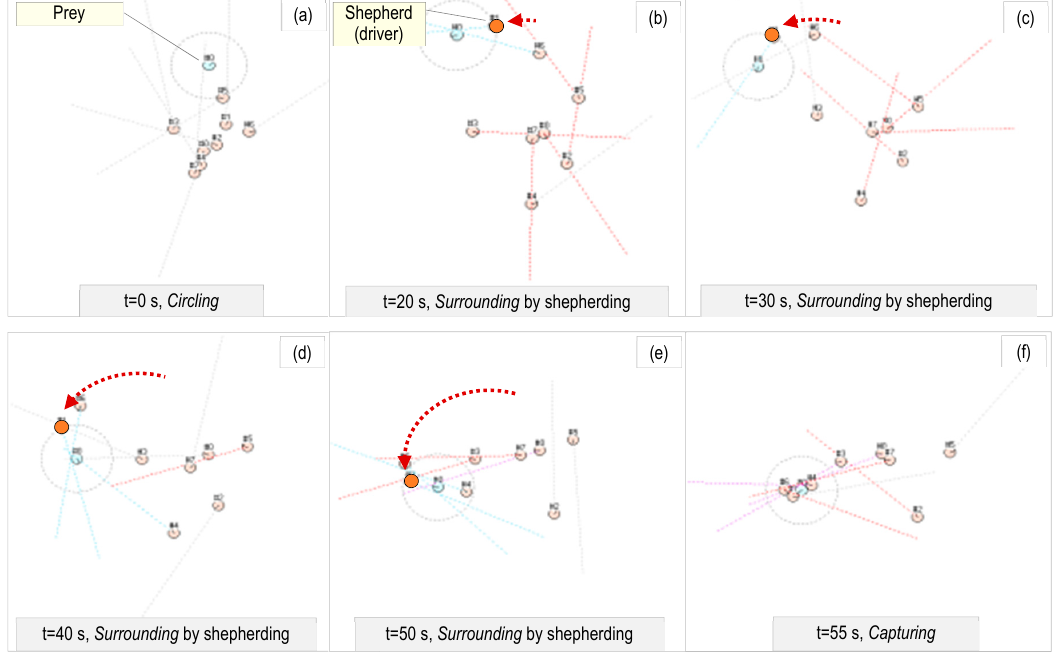
Figure 9. Emergent behavioral strategies of a sample evolved team of predator agents with sensor offset of 20 ◦ . Environmental state perceived by predator: grey = <00>, red = <10>, blue = <01>, purple =